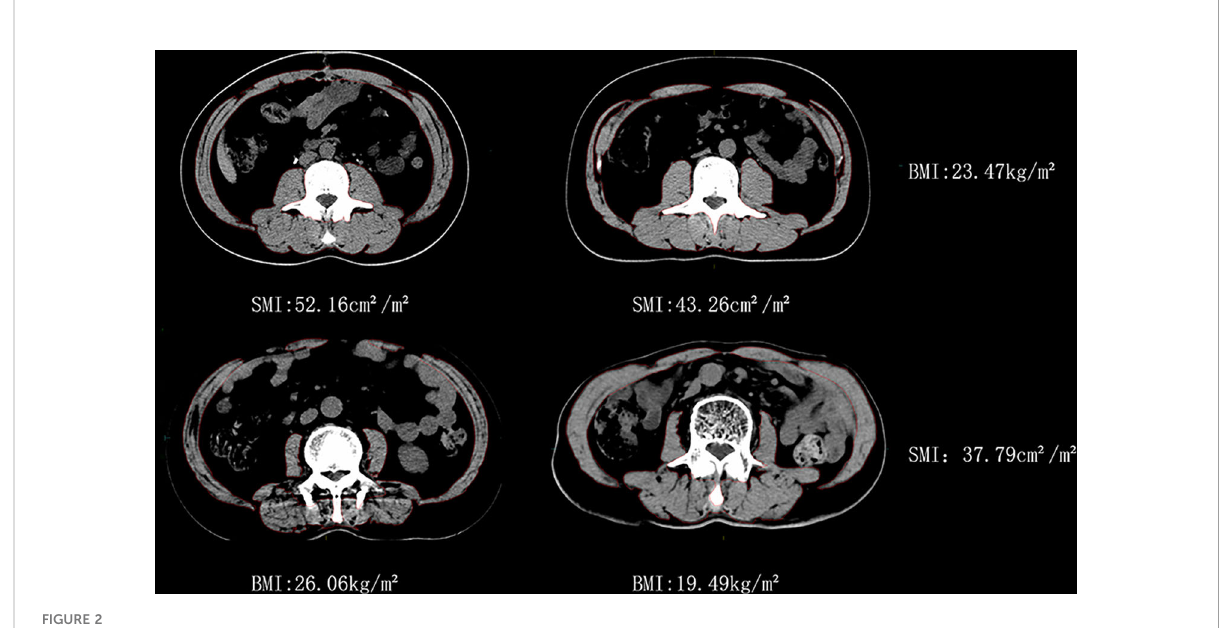
FIGURE 2 Similar BMI with different SMI vs similar SMI with different BMI for man patients.